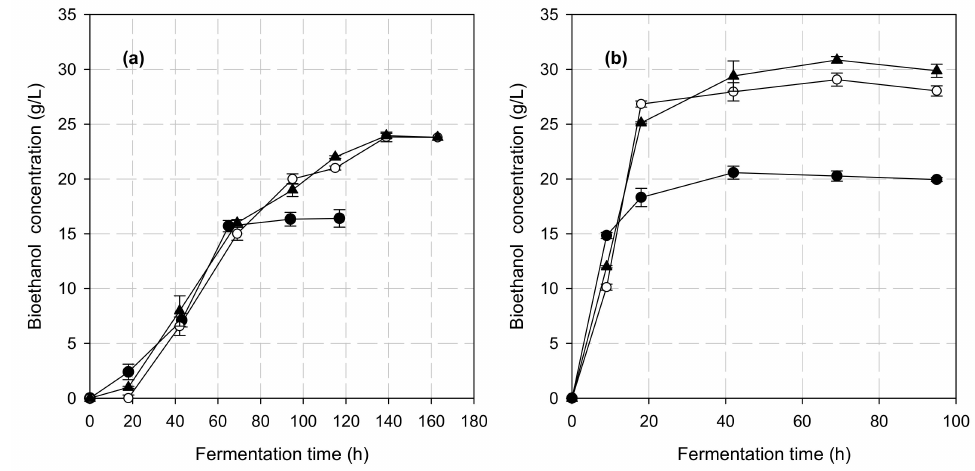
Figure 3. Bioethanol production from FW by ( a ) mono-culture of F. oxysporum F3 ( • ), supplemented with 20 ( ) and 40 ( (cid:78) ) Units / g starch Spirizyme ® Fuel; and ( b ) mixed microbial culture of F. oxysporum (cid:35) F3 with the yeast S. cerevisiae ( • ), supplemented with 20 (